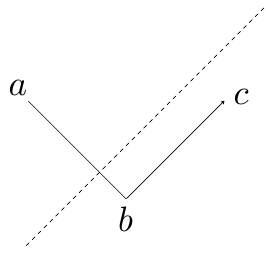
Figure 1 . A trajectory from inside to outside of the black hole. The dashed line represents the event